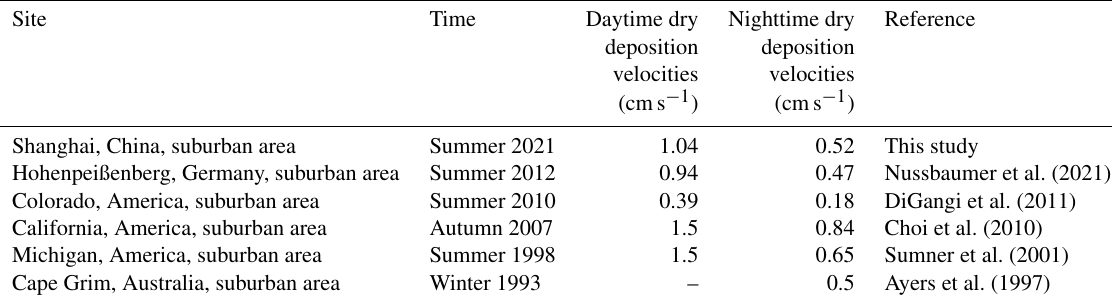
Table 2. A summary of HCHO deposition velocities.